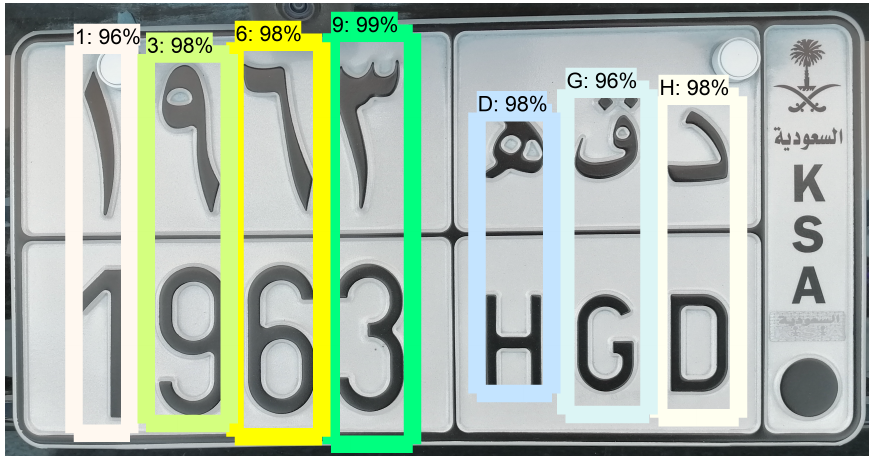
Figure 9. Example of double-character detection on a test image. Table 7. Number of images and instances in the double-character detection dataset. Training